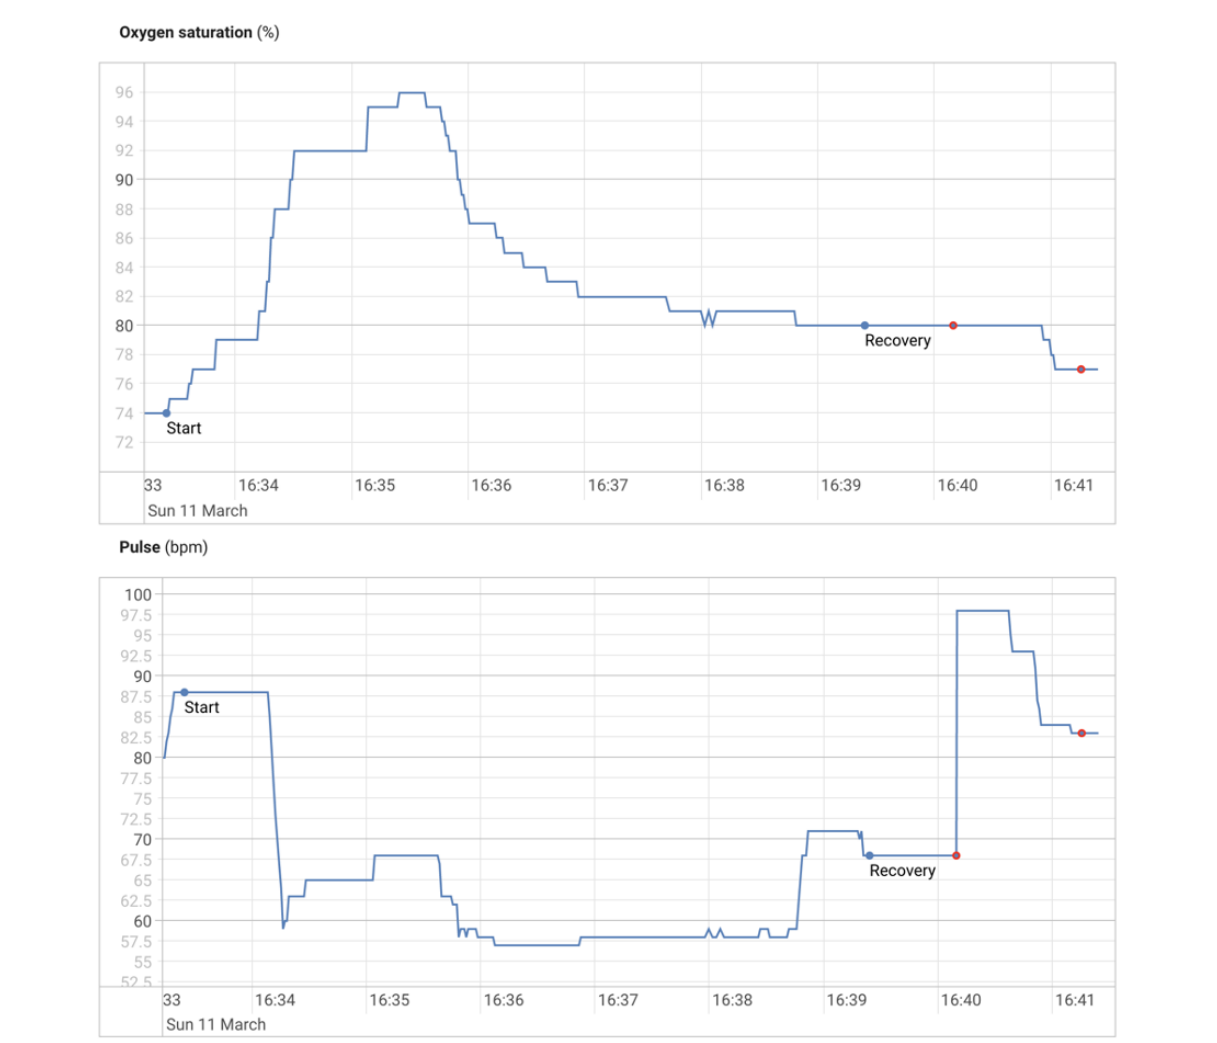
Figure 7. SpO 2 and heart rate for a test where the SpO 2 increases during exertion and the heart rate decreases. SpO 2 : peripheral oxygen